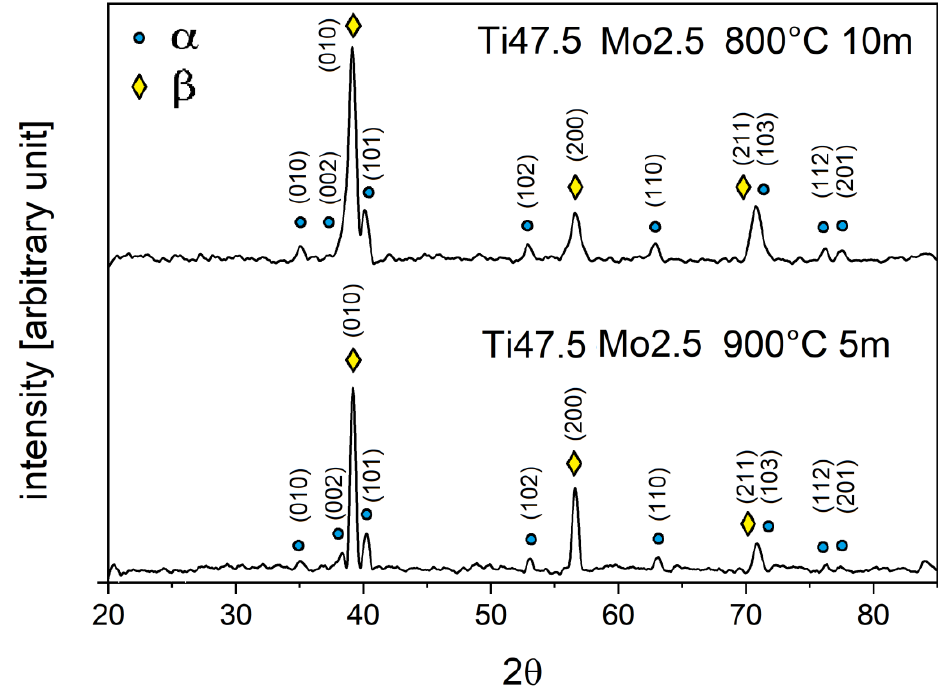
Figure 1. X-ray di ff raction patterns of the porous TiMo alloy obtained by dealloying at 800 ◦ C for Figure 1. X-ray diffraction patterns of the porous TiMo alloy obtained by dealloying at 800 °C for 10 10 min (upper diagram) and 900 ◦ C for 5 min (lower min (upper diagram) and 900 °C for 5 min (lower diagram).